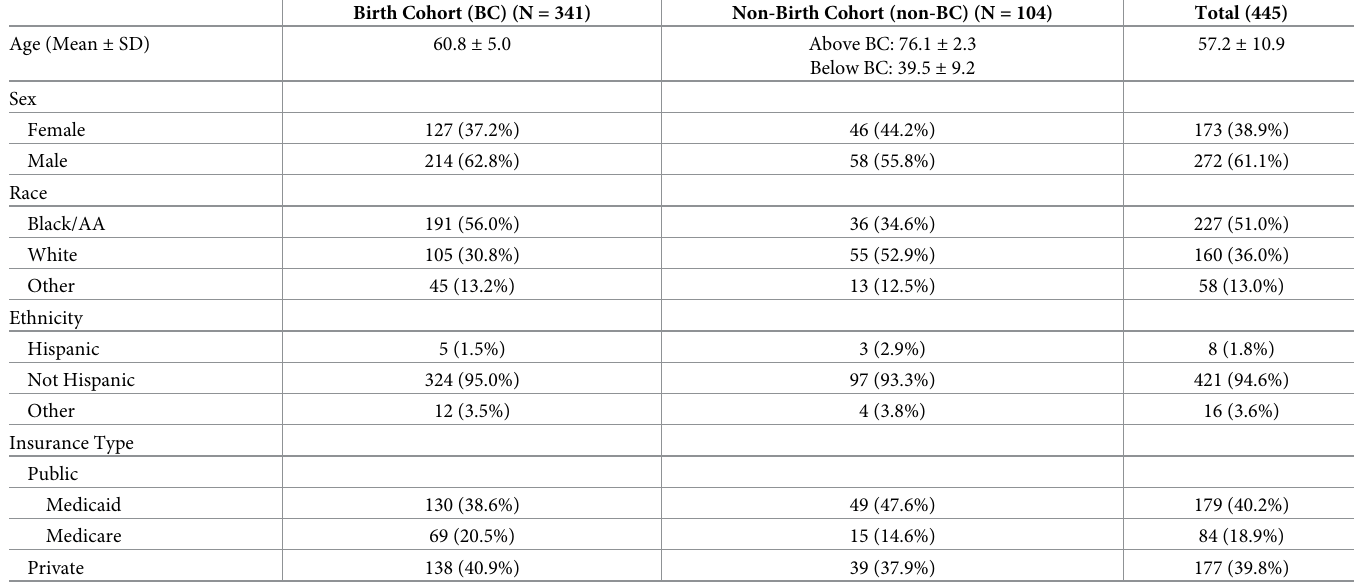
Table 1. Patient baseline